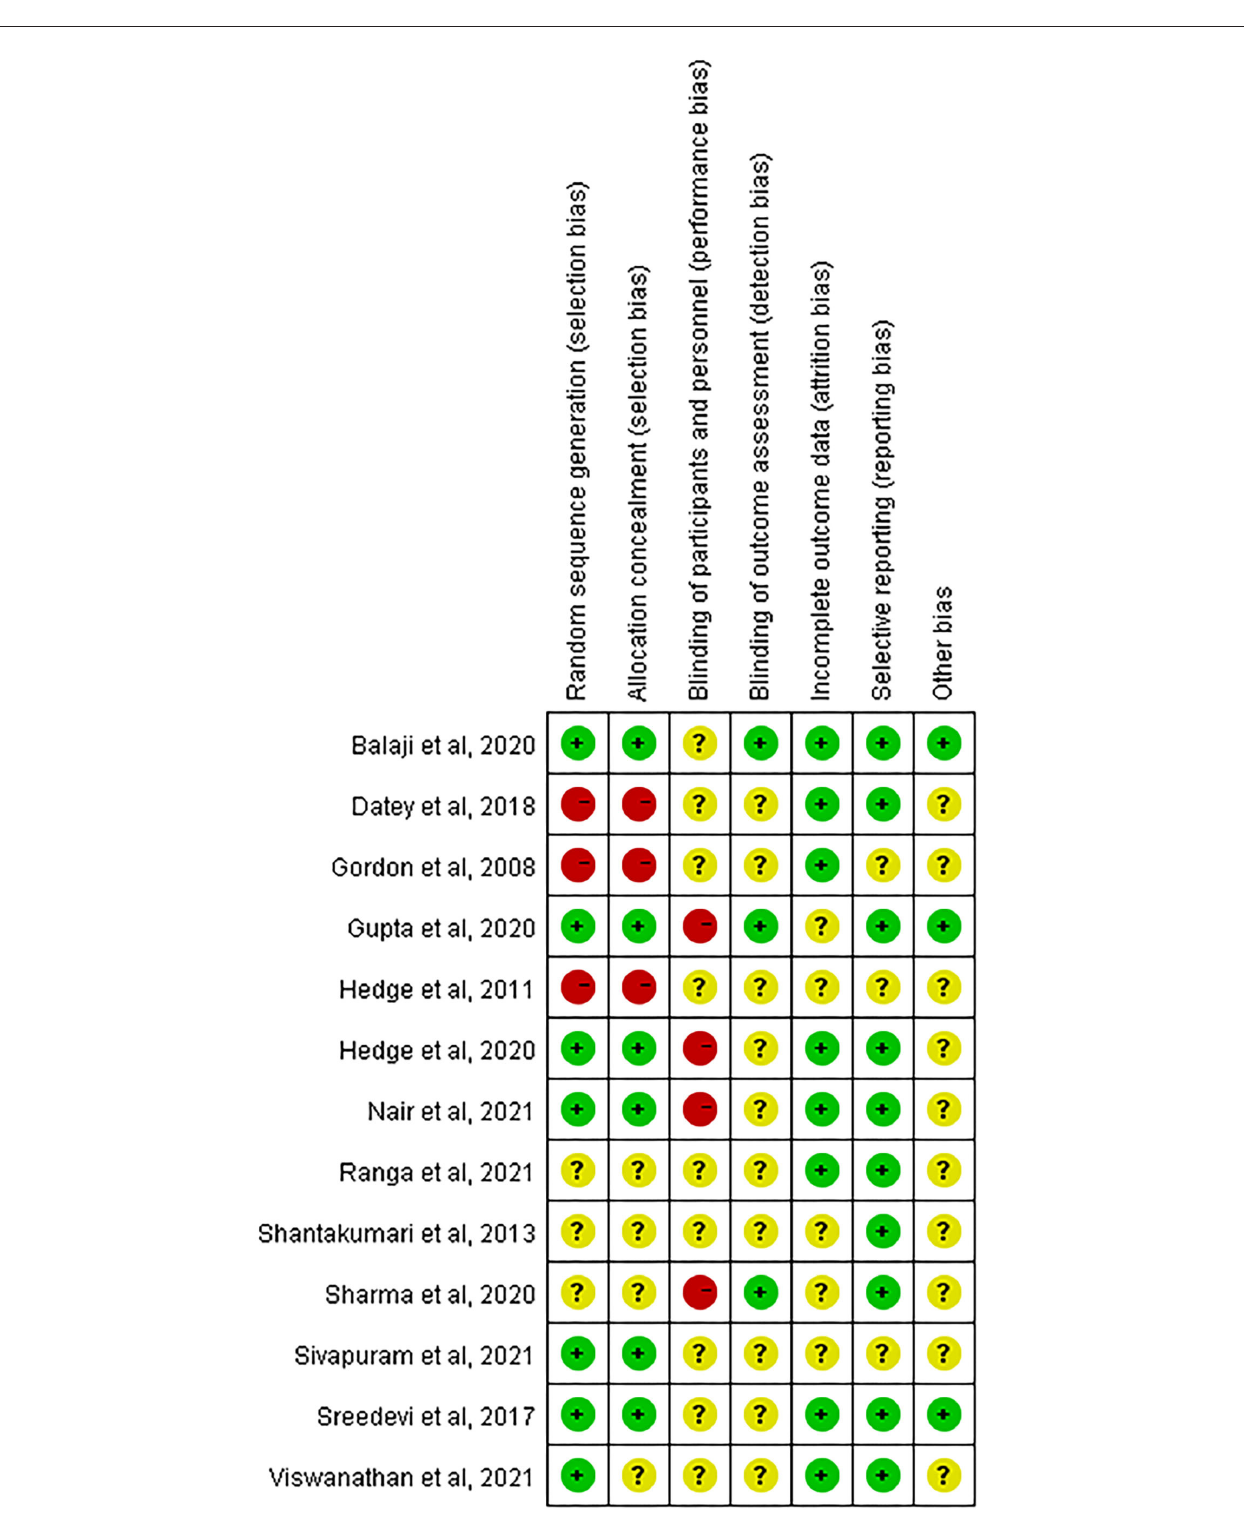
Frontiers in Sports and Active Living |